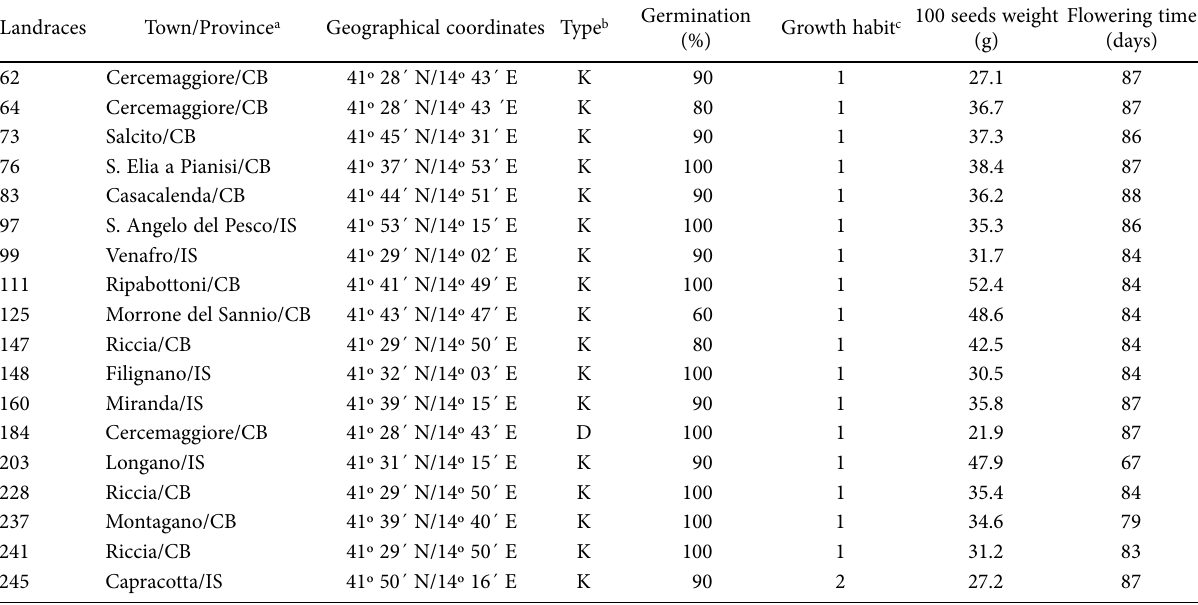
Table 1. Geographical origins and agronomic traits of Italian chickpea landraces assessed in this study.